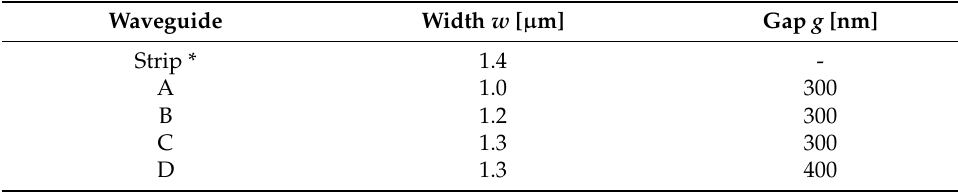
Table 1. Geometries of the fabricated CSA